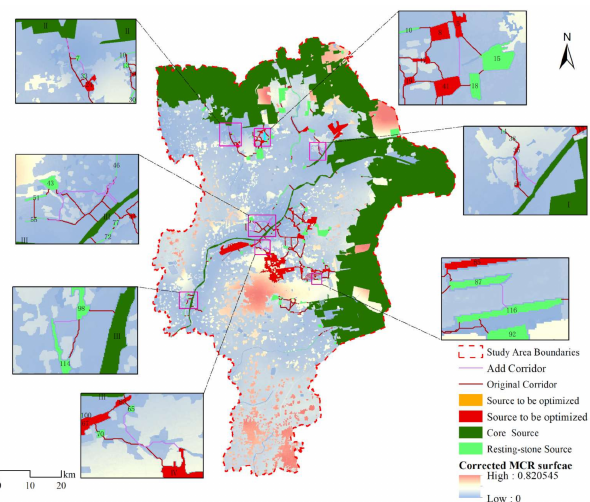
Figure 9. Spatial distribution of edge extension in resting-stone source of Dongying